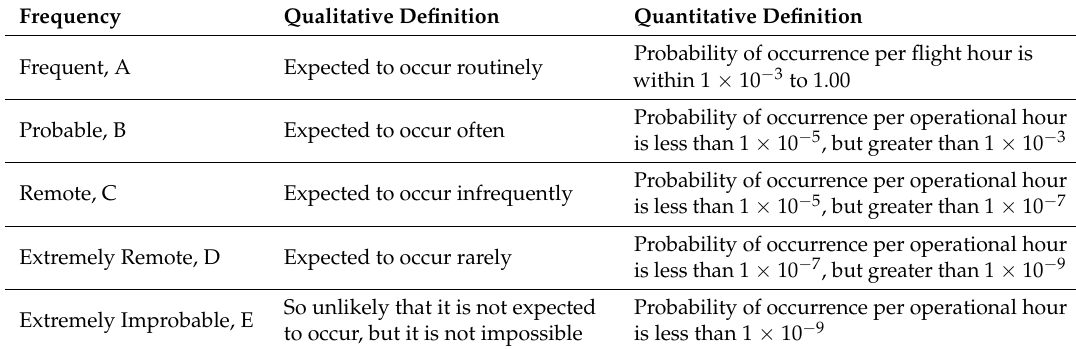
Table 8. Likelihood definition.